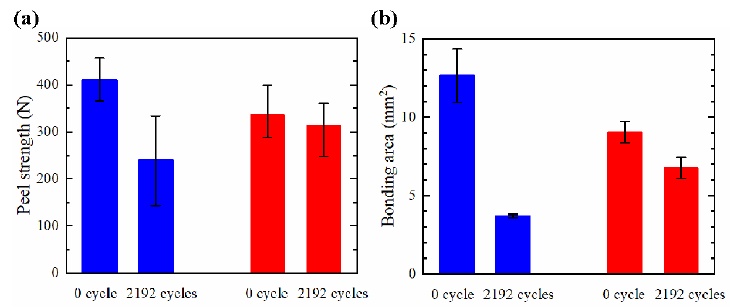
Figure 7. Results of ( a ) peel strength and ( b ) bonding area of the C1020 joints and the C1940 joints before and after the thermal cycling test.